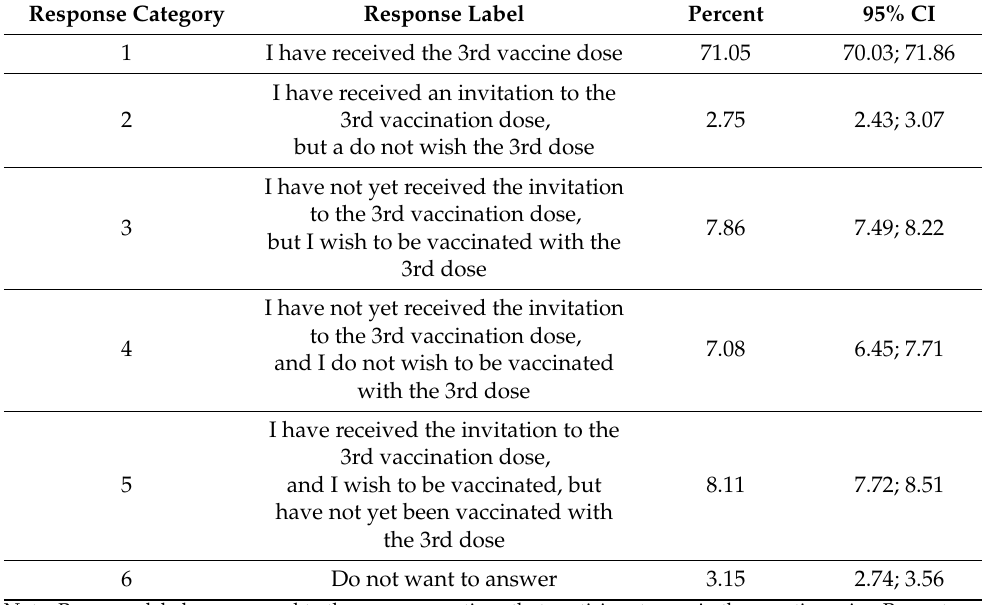
Table 2. Distribution of